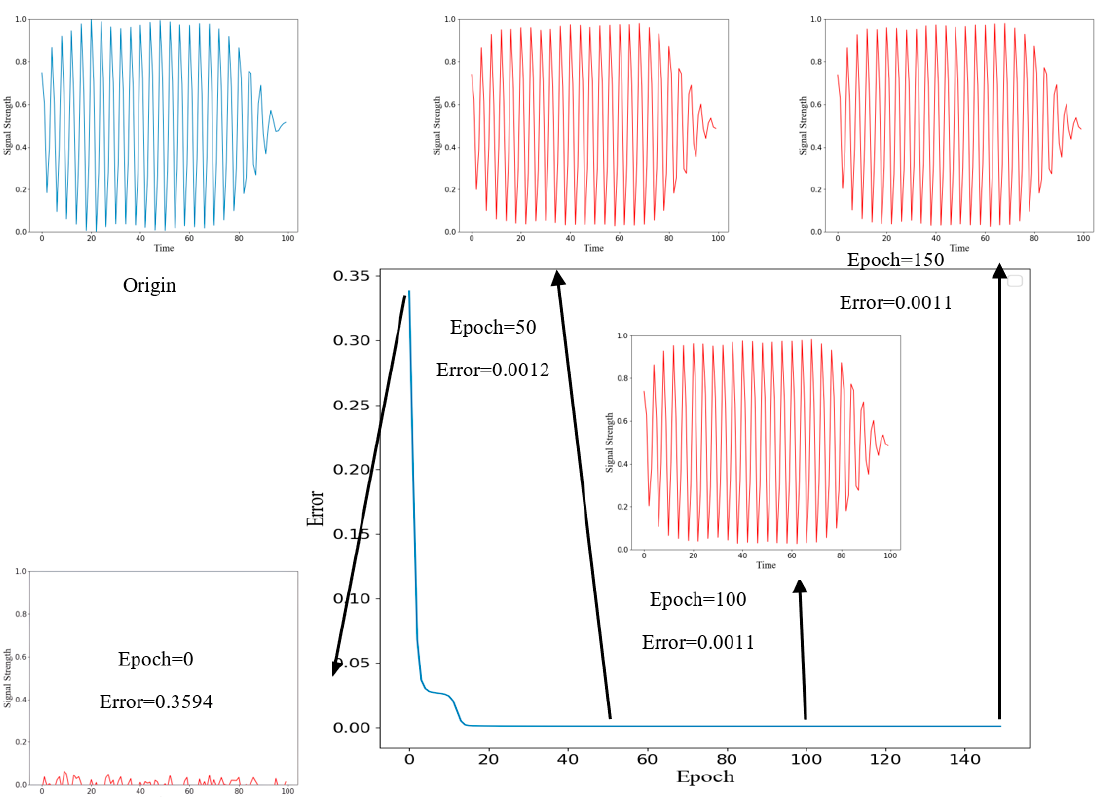
Figure 4. Reconstructed signal during training.